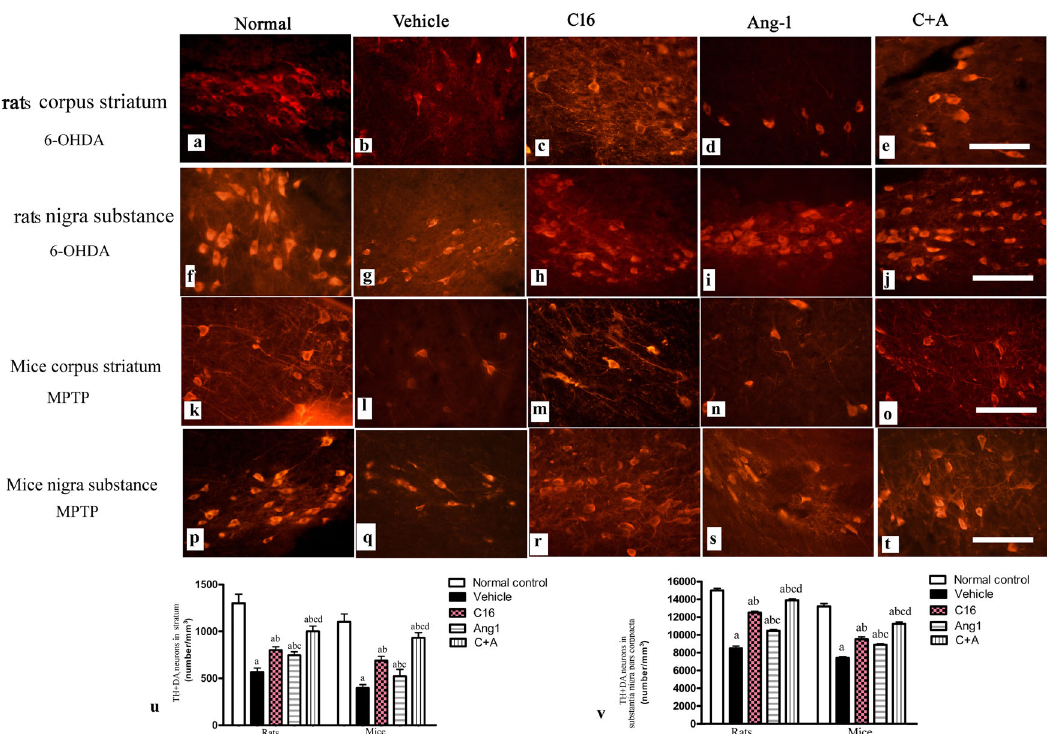
Fig. 8 C16 in combination with Ang-1 treatment rescued the TH neurons. a – t The DA neurons were stained using anti-TH (red) in both the nigra substance and striatum of PD rats (induced by 6-OHDA) and PD mice (induced by MPTP). Treatment with C16 ( c , h , m , r ), Ang-1 ( d , i , n , s ), and especially the combination of C16 and Ang-1 ( e , j , o , t ) reduced DA neuron loss in PD models ( b , g , l , q ). Panel a , f , k , p show DA neurons in normal controls. Scale bar = 100 µm. u , v Stereological analysis of DA neurons in the corpus striatum ( u ) and SN ( v ). a p < 0.05 versus the normal control group; b p < 0.05 versus the vehicle group; c p < 0.05 versus the C16-treated group; d p < 0.05 versus the Ang-1-treated group. DA, dopamine; TH, tyrosine hydroxylase; GABA, gamma-aminobutyric acid; MPTP, 1-methyl-4-phenyl-1,2,3,6-tetrahydropyridine; 6-OHDA, 6- hydroxydopamine; C16, peptide (KAFDITYVRLKF) that can selectively bind integrin α ν β 3 ; Ang-1 angiopoietin-1; PD, Parkinson ’ s